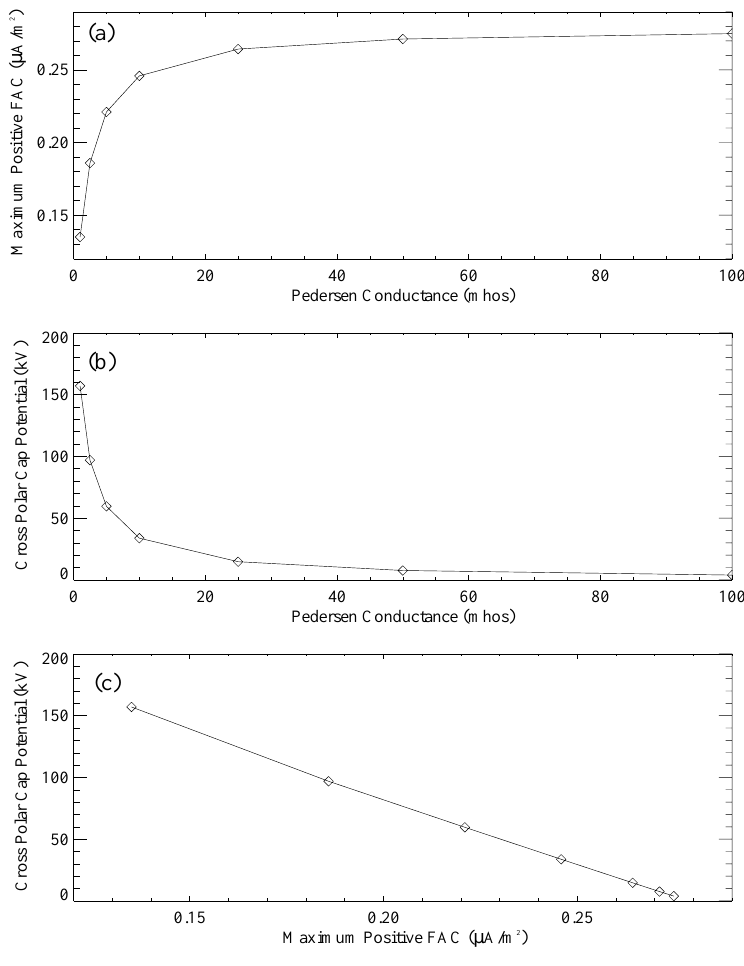
Fig. 1. (a) The maximum field-aligned current into the ionosphere and (b) the cross polar cap potential versus the Pedersen conductance. (c) The maxi- mum field-aligned current into the iono- sphere versus the cross polar cap poten-